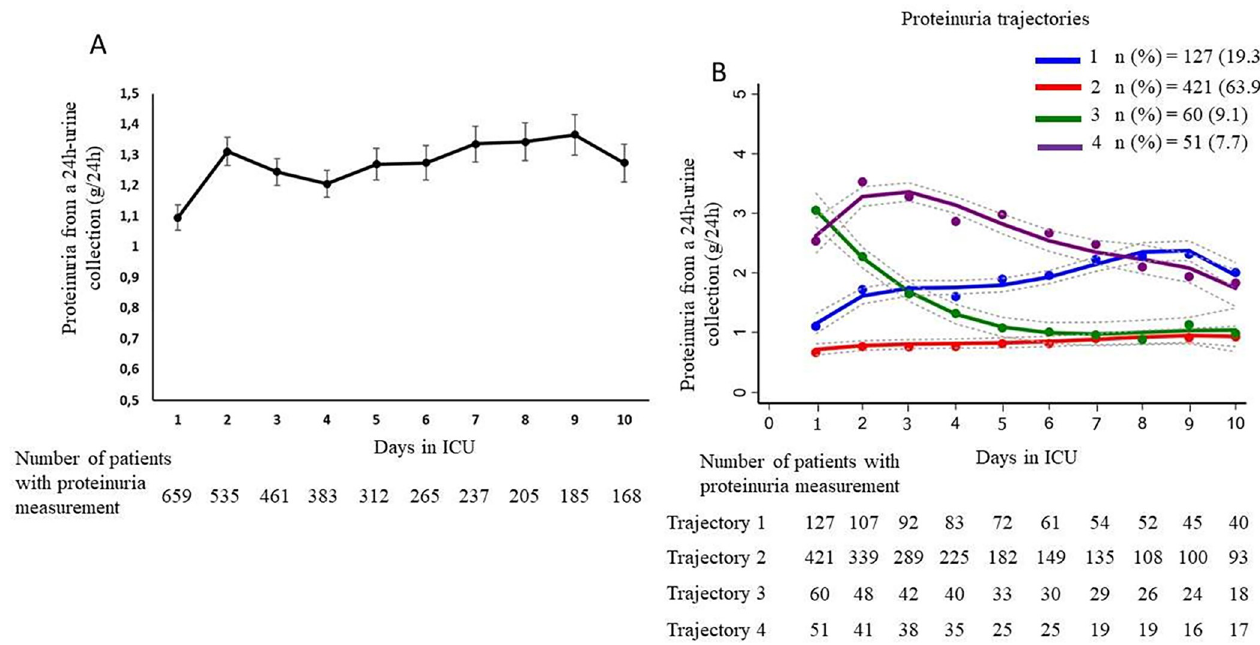
Fig 1. Change of proteinuria within the first 10 days in ICU. A. Mean proteinuria of the study population within the first 10 days in ICU. B. Proteinuria trajectories during the first 10 days in ICU. blue curve: trajectory 1; red curve: trajectory 2; green curve: trajectory 3; purple curve: trajectory 4. The dotted lines correspond to the standard